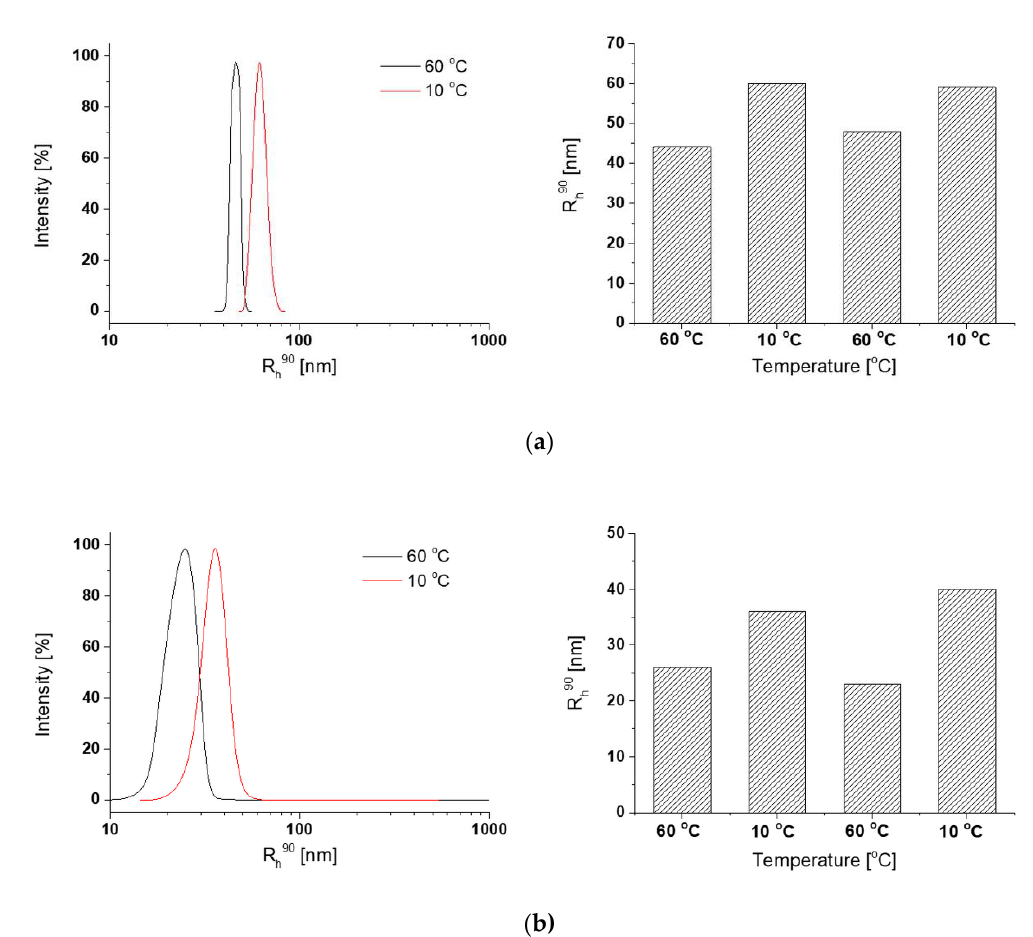
Figure 5. Exemplary size distributions of the crosslinked nanoparticles formed in aqueous solutions and the changes of their radii during heating and cooling cycles at total concentration 0.5 g / L of ( a )